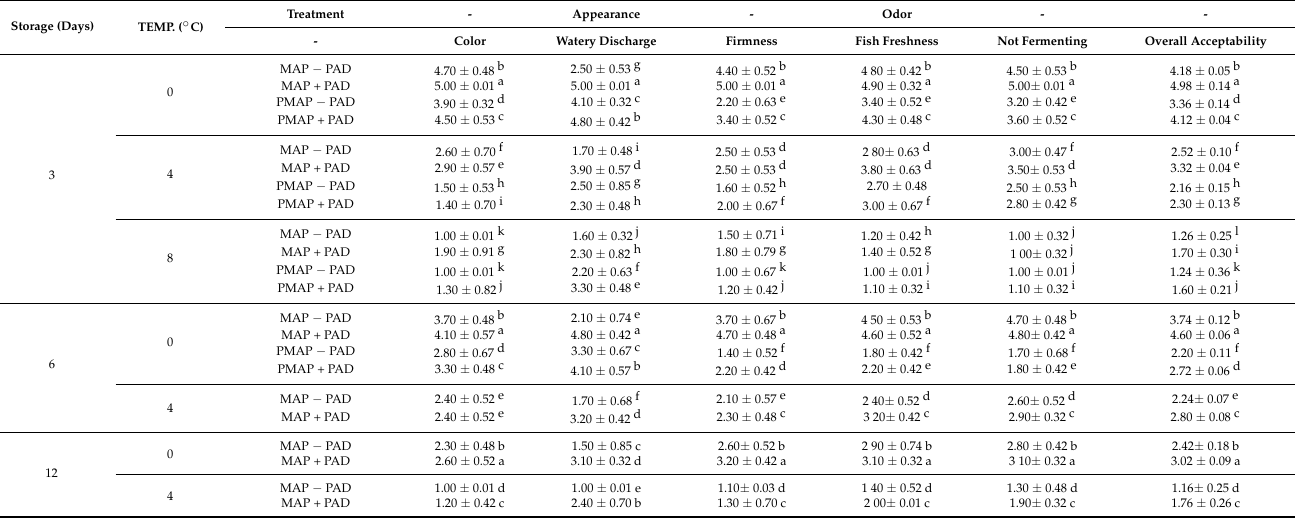
Table 2. Consumer perception scores of packaged Cape hake fillets during